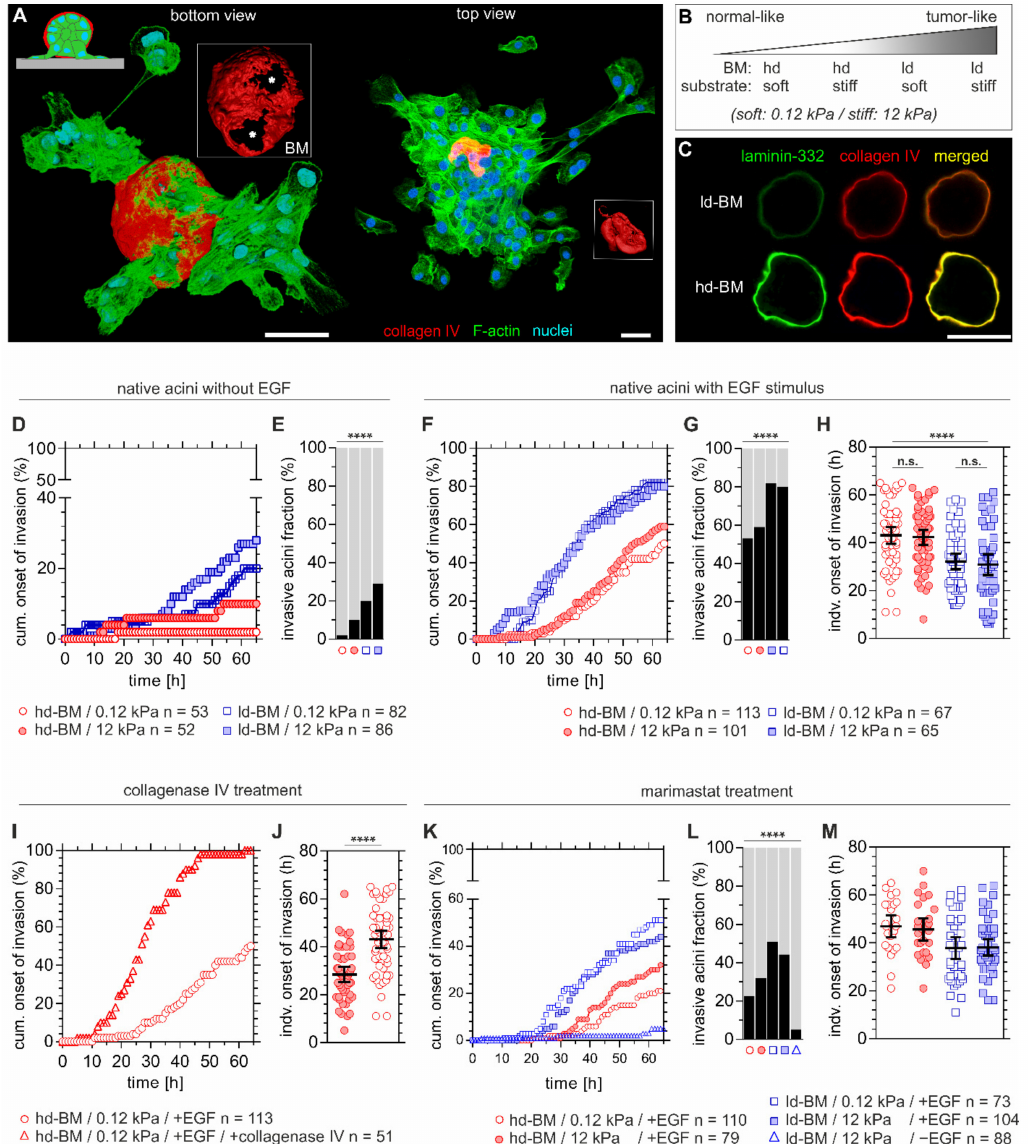
Figure 1. Basement membrane (BM) mechanics counteract tumour extracellular matrix (ECM)-induced invasion. ( A ) 3D reconstructed confocal images showing a local basement membrane (BM) disruption and cell invasion event (left acinus) on a 12 kPa PDMS silicone rubber substrate. Left: Local BM disruption foci (asterisks) and collective cell transmigration are present at the cell–BM–substrate interface. Right: Massive cell dissemination and a collapsed, cell-free BM hull (red), indicating the late invasion phase. ( B ) Experimental conditions to resemble the shift from physiological to malignant breast tissue states by altering BM development and substrate compliance. ( C ) MCF10A breast acini-derived BMs with progressive developmental stages. Micrographs are illustrating ld-BM and hd-BM structures with representative increasing deposition of BM-specific marker proteins type IV collagen and laminin-332. ( D ) Cumulative events of BM transmigration onset over time and ( E ) fraction of invasive acini after 65 h and different BM states and substrate compliance levels. ( F ) Cumulative BM transmigration onset, ( G ) fraction of invasive acini after 65 h and ( H ) and individual invasion times for EGF-pretreated acini, comparing again different BM states and substrate compliance levels. ( I ) Cumulative BM transmigration after type IV collagenase and EGF pretreatment and ( J ) corresponding individual times of invasion for hd-BM acini soft substrate. ( K ) Cumulative BM transmigration, ( L ) fraction of invasive acini after 65 h and ( M ) corresponding times of invasion for individual acini after pretreatment with MMP inhibitor marimastat, again for different BM states, substrate compliance levels and ± EGF. n: sample size of at least three independent experiments (see Table S1 for exact invasive fraction values and mean invasion timepoints). Scatter plots ( H , J , M ): bars: mean with 95% confidence interval (CI). Scale bars: 50 µ m; n.s.: p ≥ 0.05; ****: p <